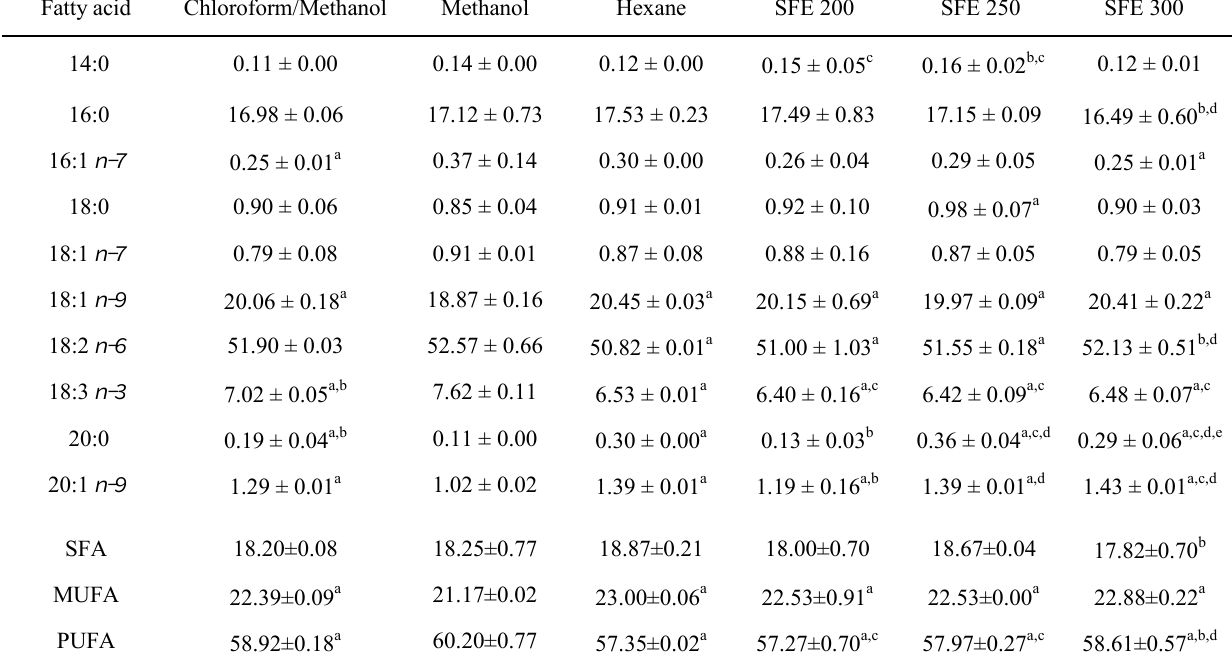
Table 1. Fatty acids composition (expressed as % of total fatty acids), measured by a gas chromatography-flame ionization detection (GC-FID) method, of wheat germ oil obtained by different extraction procedures.